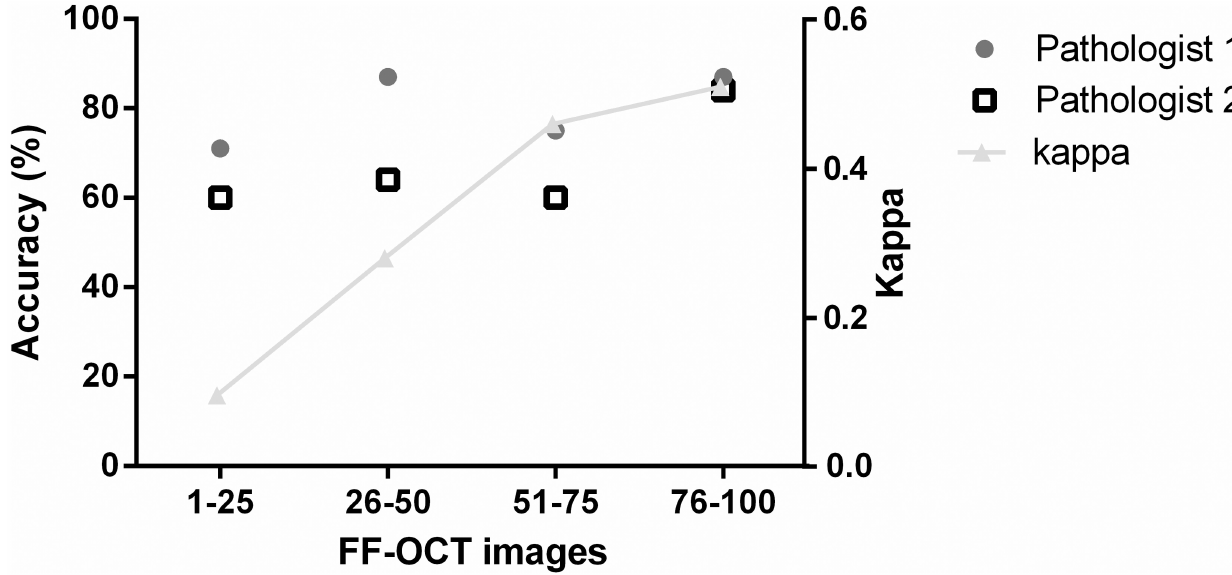
Fig 5. Accuracy and interobservervariability. Pathologist 1 is the experienced pathologist, pathologist 2 is the pathologist in training.